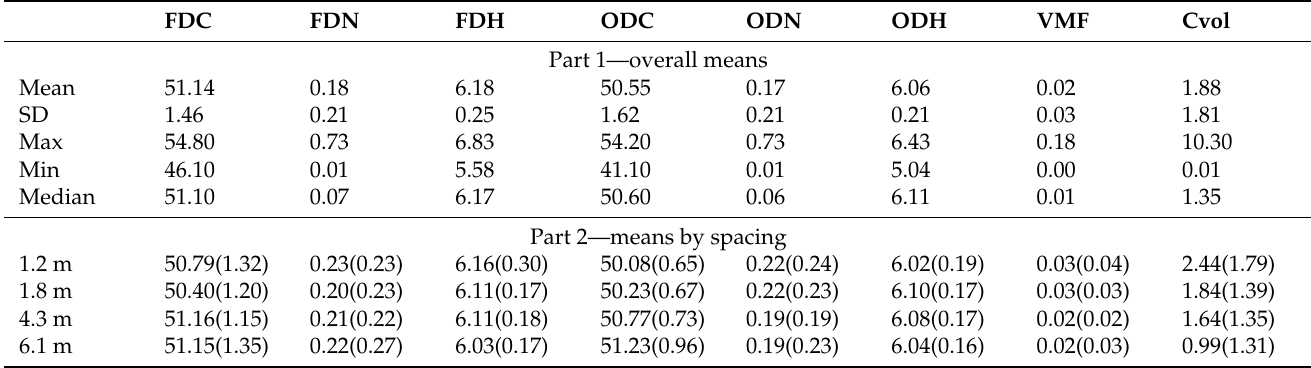
Table 1. Summary of chemical characteristics of spaced spruce trees.